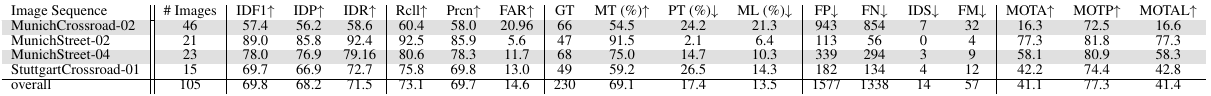
Table 3. Quantitative results of our multi object tracking ablation study for the Person dataset with the total number of 1043 people. The sequences are of 1.1 Hz. ↑ and ↓ stand for “higher and lower is better” accordingly. ImageSequence